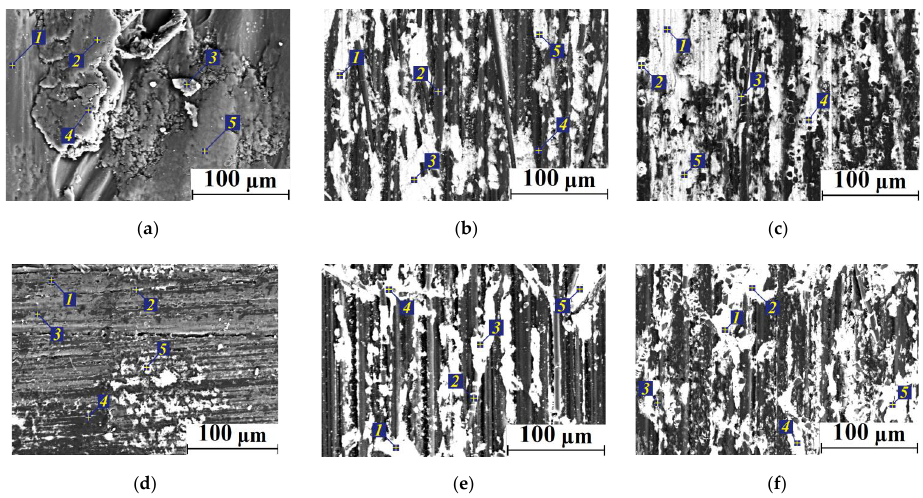
Figure 8. The SEM micrographs of the wear track surfaces after the tribological tests of neat PI ( а ), PEI ( d ), as well as the PI/10CCF ( b ), PEI/10CCF ( e ) and PI/10CCF/10Gr ( c ), PE/10CCF/10Gr ( f ) composites.